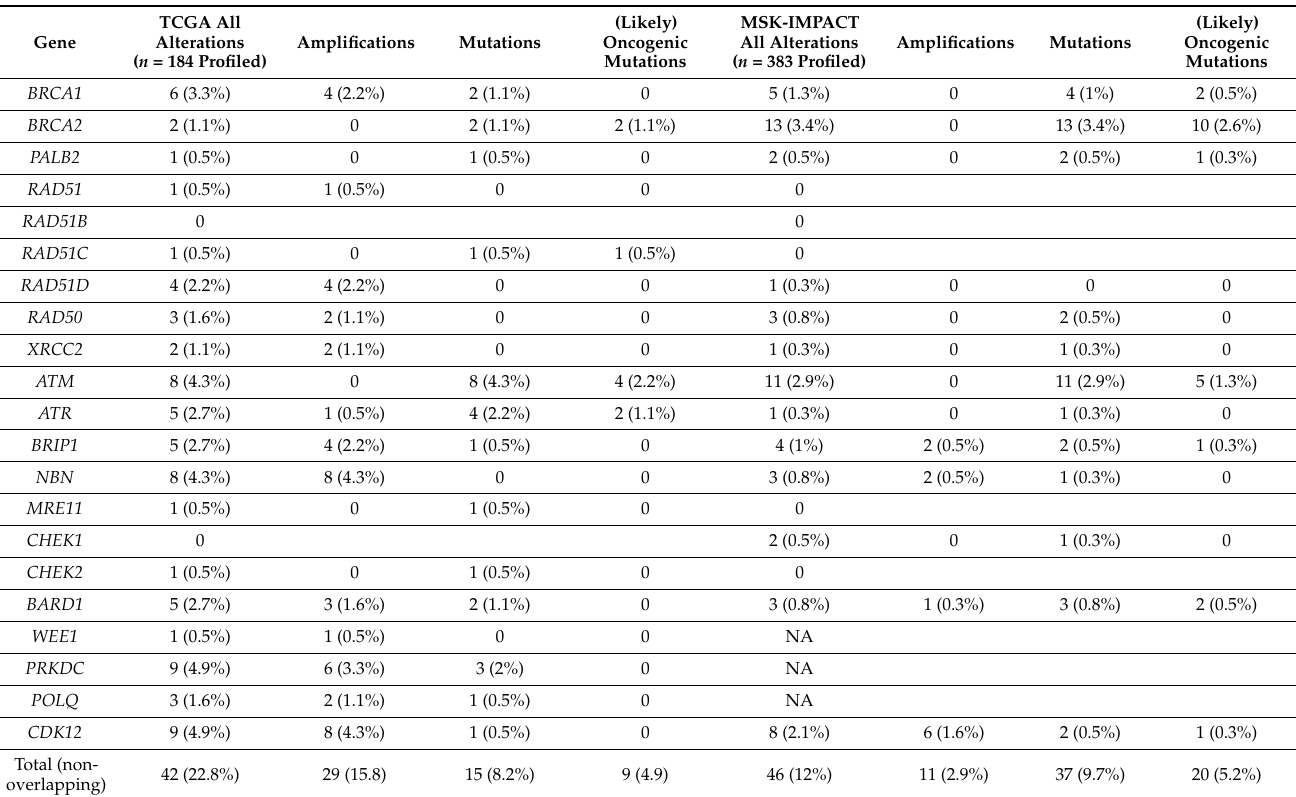
Table 1. Alterations in DDR-related genes in pancreatic cancers from TCGA and MSK-IMPACT cohorts. NA: not